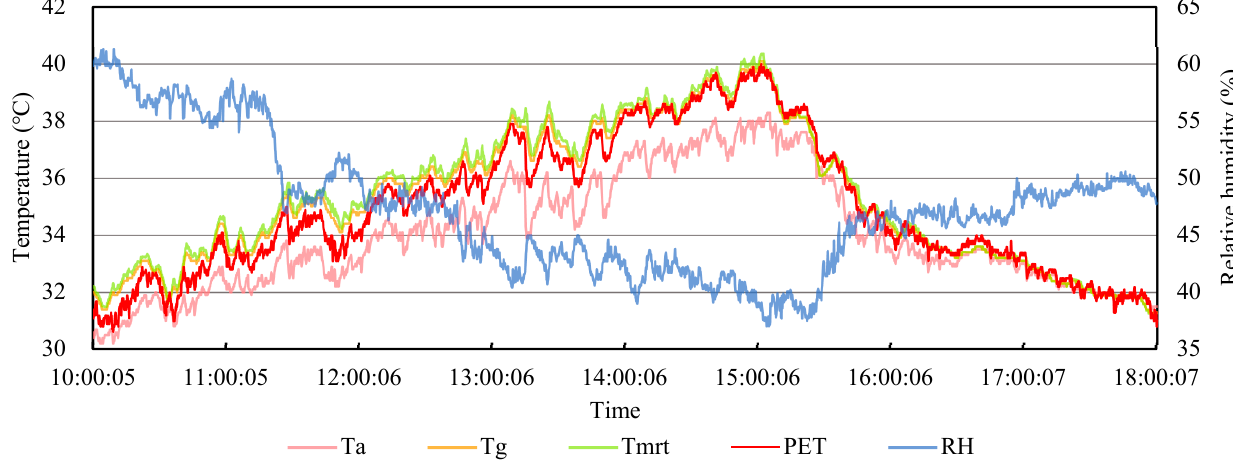
Figure 4. Temporal trend of strongly correlated thermal comfort parameters.